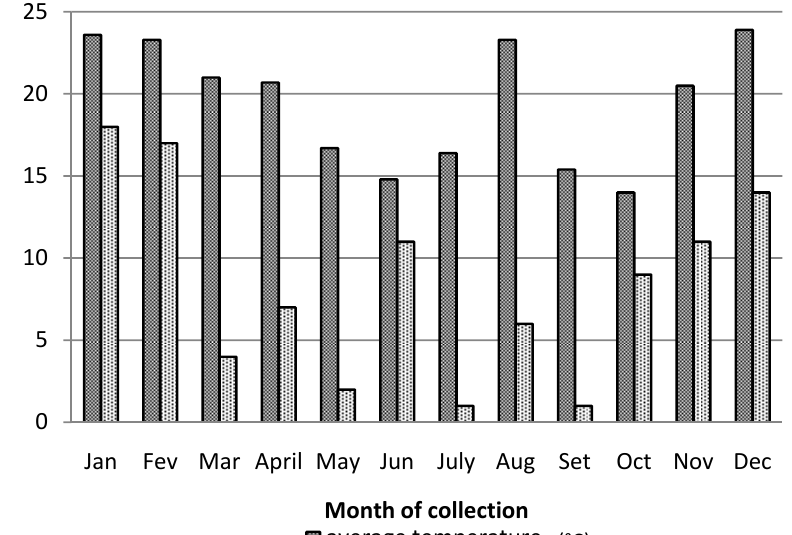
Figure 1. Average monthly temperatures (°C) and precipitation (×10 mm) values in 2011 (collection